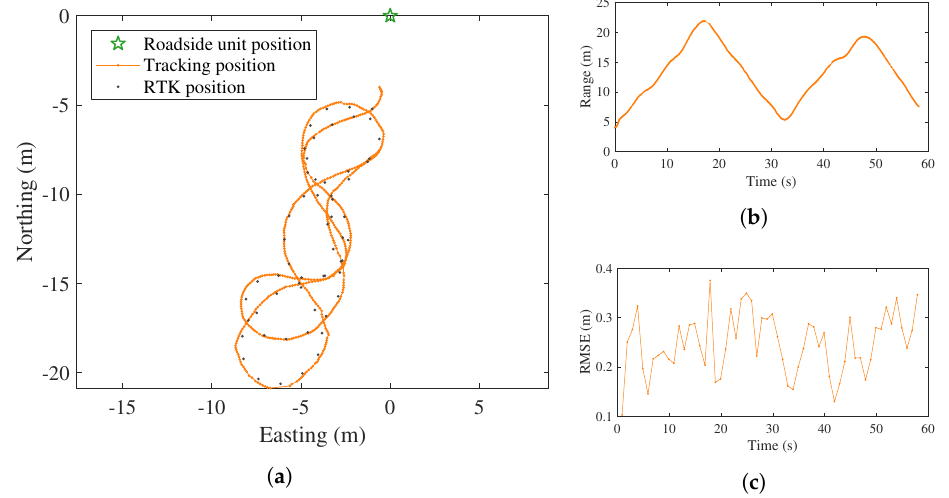
Figure 4. Pedestrian tracking results for the IRSU. It can be seen in ( a ) that, when the target pedestrian was walking in a figure eight pattern in front of the IRSU, the tracked positions are found to be well aligned with the ground truth path obtained from an RTK receiver. The distance of the pedestrian relative to the IRSU changes between 5 and 22 m, as depicted in ( b ). In ( c ), the position RMSE is found to be lower than 0.3 m for the majority of the time in the